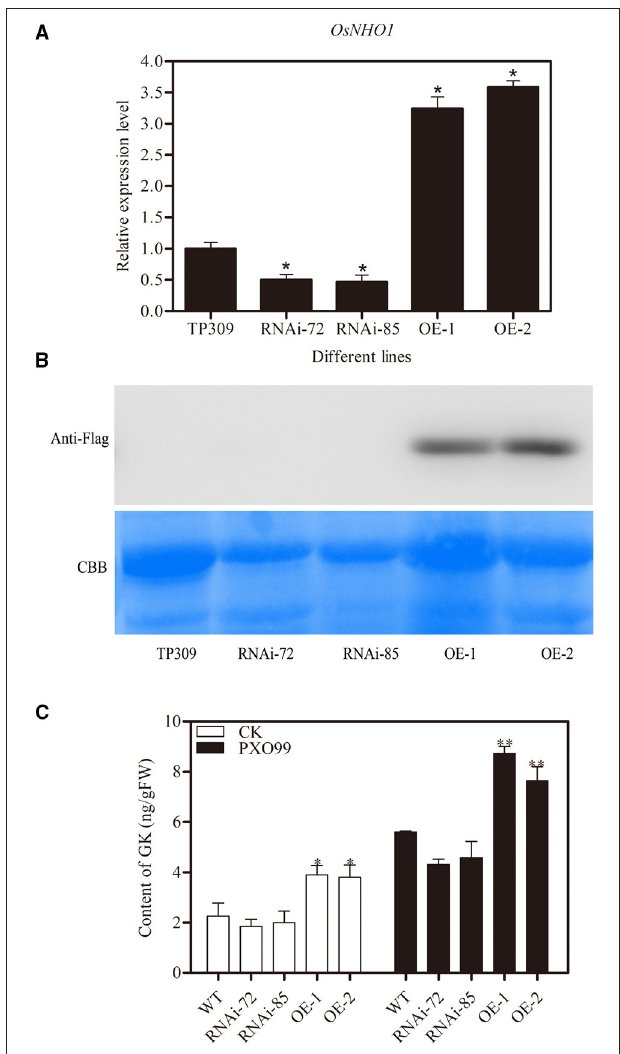
FIGURE 4 | Identification of transgenic materials. (A) OsNHO1 transcript levels in RNAi, OE, and WT (TP309) plants by qPCR. (B) Protein-level determination in different plants. (C) Content of GK in different transgenic plants. GK, glycerol kinase; OE, overexpression; WT, wild type. * indicates a significant difference at the 0.05 level; ** indicates a significant difference at the 0.01